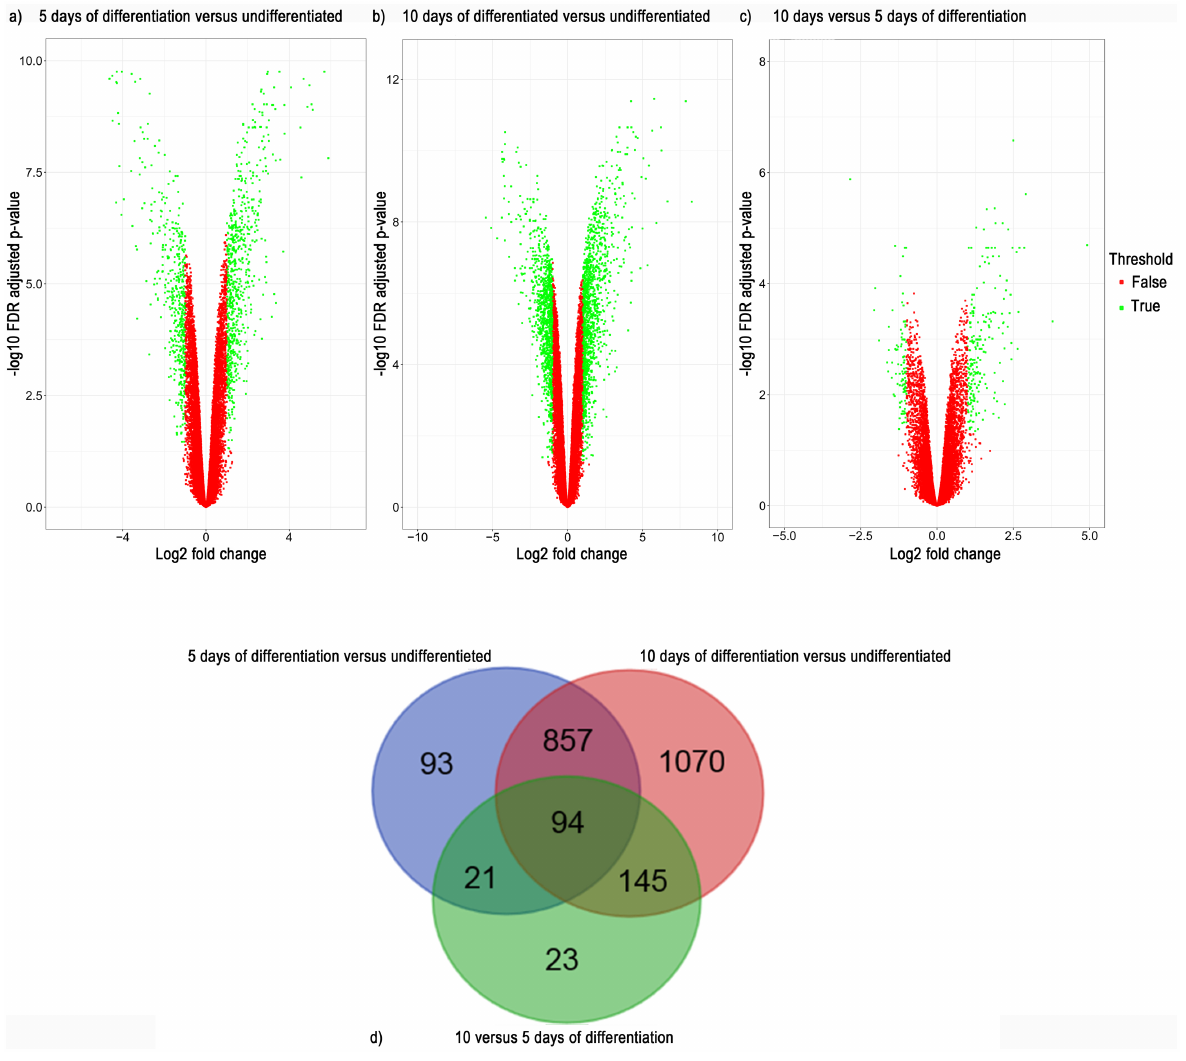
Fig 2. Volcano plot showing genes in and outside of cutoff values for differentially expressedgenes (i.e. adjusted p- value (cid:20) 0.05 and absolute log2(fold change) > 1). Red dots representgenes outsideof the cutoff values and green dots represents differentially expressedgenes at a) 5 days of differentiation vs undifferentiated cells b) 10 days of differentiation vs undifferentiated cells c) 10 days vs 5 days of differentiationd) Venn diagramshowingoverlap of differentiallyexpressedgenes betweenthe different time